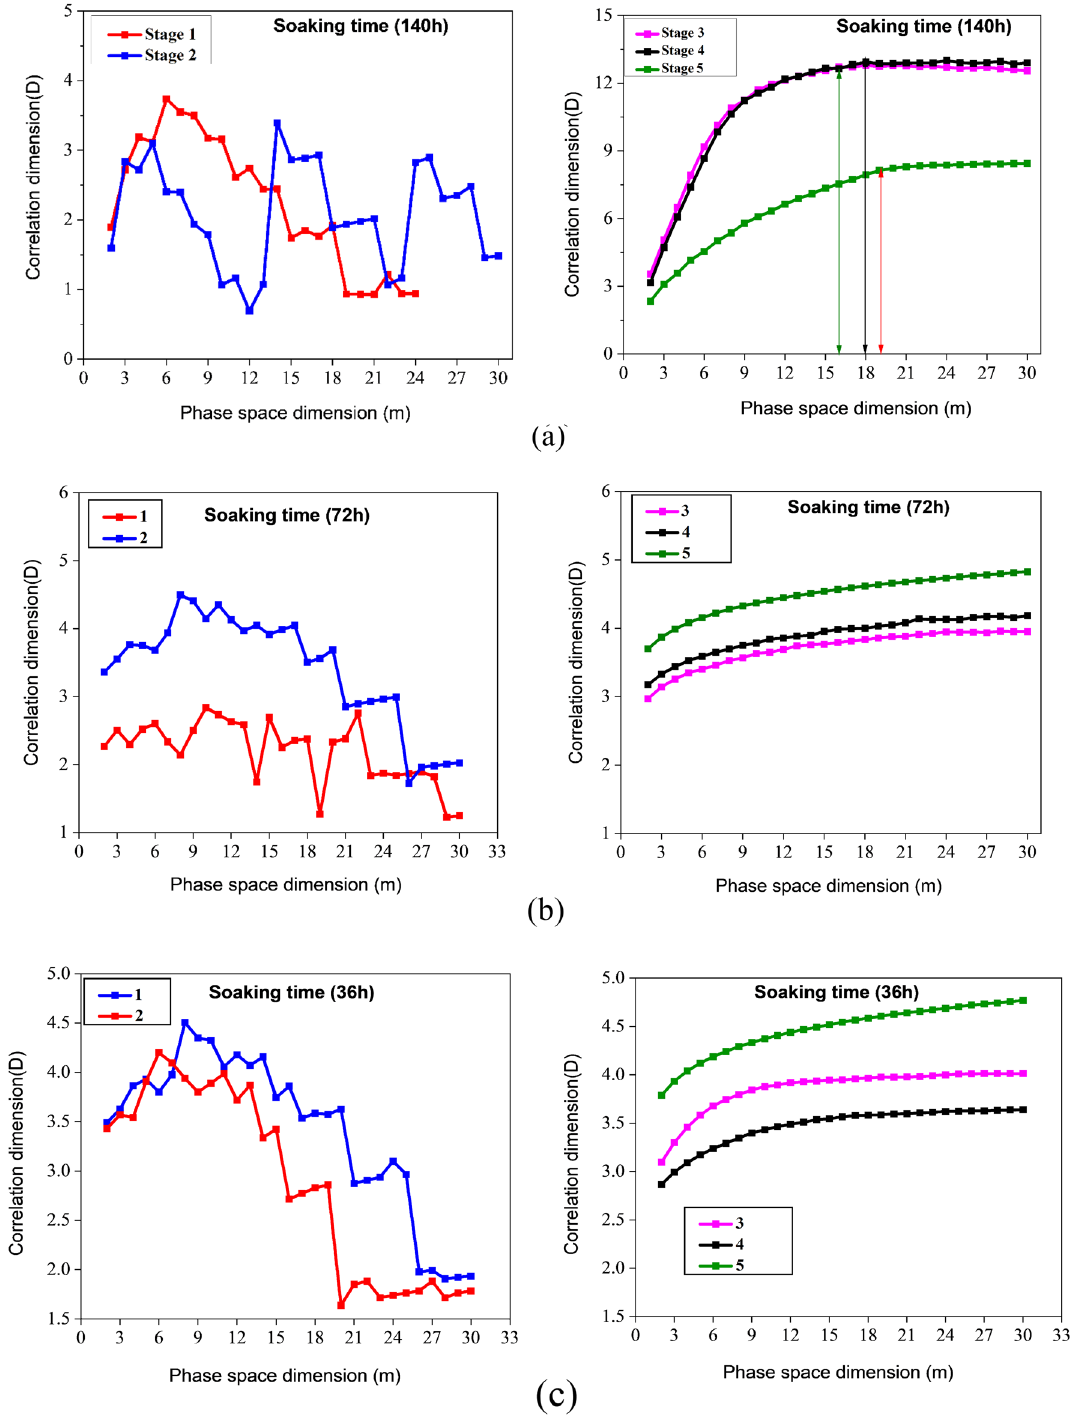
Figure 10. Coal sample AE signal phase space and correlation dimensions with various water content and soaking time during uniaxial